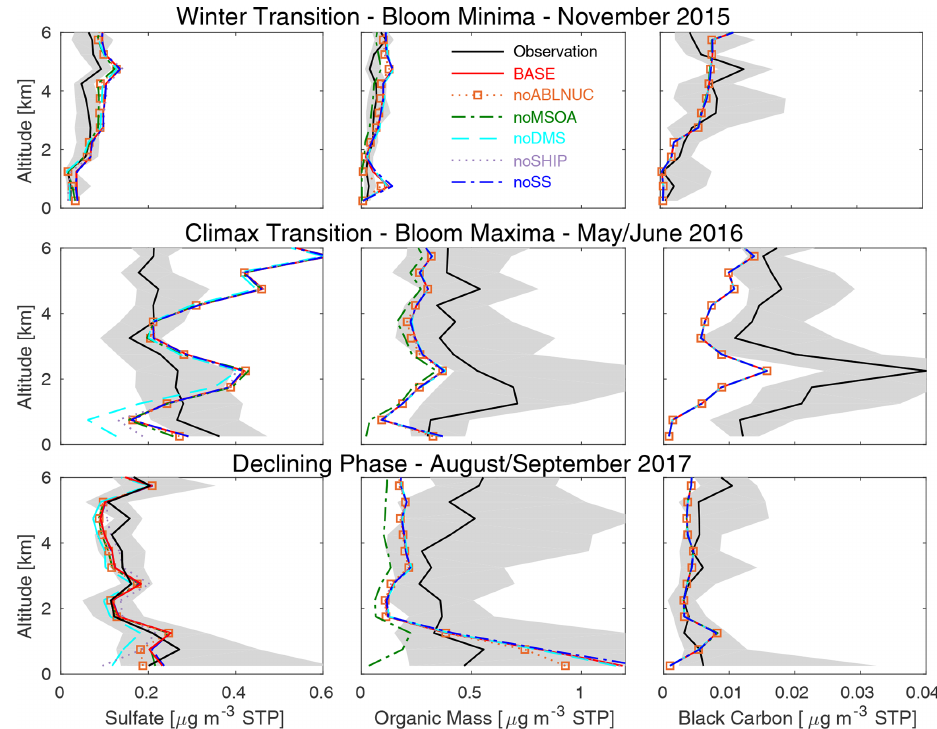
Figure 5. Vertical profiles of NAAMES campaign-median aerosol non-refractory sulfate and organic mass concentrations at standard tem- perature and pressure (STP) from aerosol mass spectrometer and refractory black carbon from single particle soot photometer observations aboard aircraft (black, with 25th–75th percentiles in grey) and for the six GEOS-Chem-TOMAS simulations described in Table 1 (color- coded as shown in the legend). Simulated sulfate shown is non-sea-salt sulfate. All measurement and model output is binned at 500m resolution, and campaign-median values are plotted at the midpoint of each bin starting at 250m above the surface. Lines show linear interpolation between these